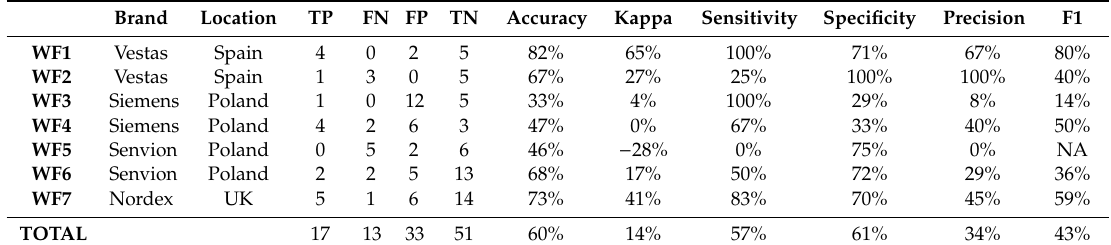
Table 7. Normality model results. WF stands for Windfarm, TP True Positive, FN False Negative, FP False Positive and TN True